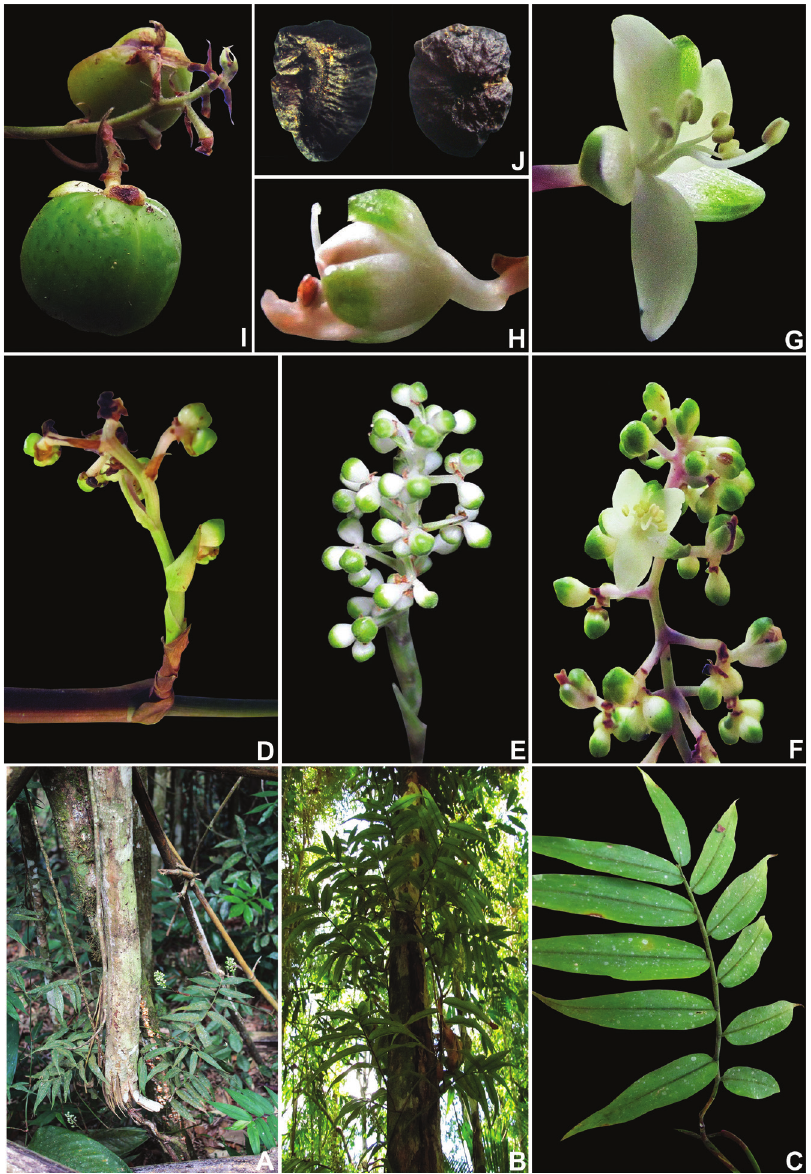
Figure 12. Siderasis zorzanellii M.Pell. & Faden. A habit, showing an immature individual B habit, showing a mature individual spirally ascending a tree C detail of a secondary branch, showing distichous- ly-alternate, asymmetric leaves D detail of an axillary inflorescence, in the primary branch E detail of a terminal inflorescence, at pre-anthesis, in a secondary branch F detail of a terminal inflorescence, at anthesis, in a secondary branch, showing an open male flower G side view of a male flower, showing the unequal and sigmoid stamens H side view of a post-anthesis bisexual flower, showing the bent style I detail of the inflorescence bearing two mature capsules J dorsal and ventral view of the seeds, showing the rugose testa, cleft towards the semidorsal embryotega, and the C-shaped hilum. Photographs by J.P.F.